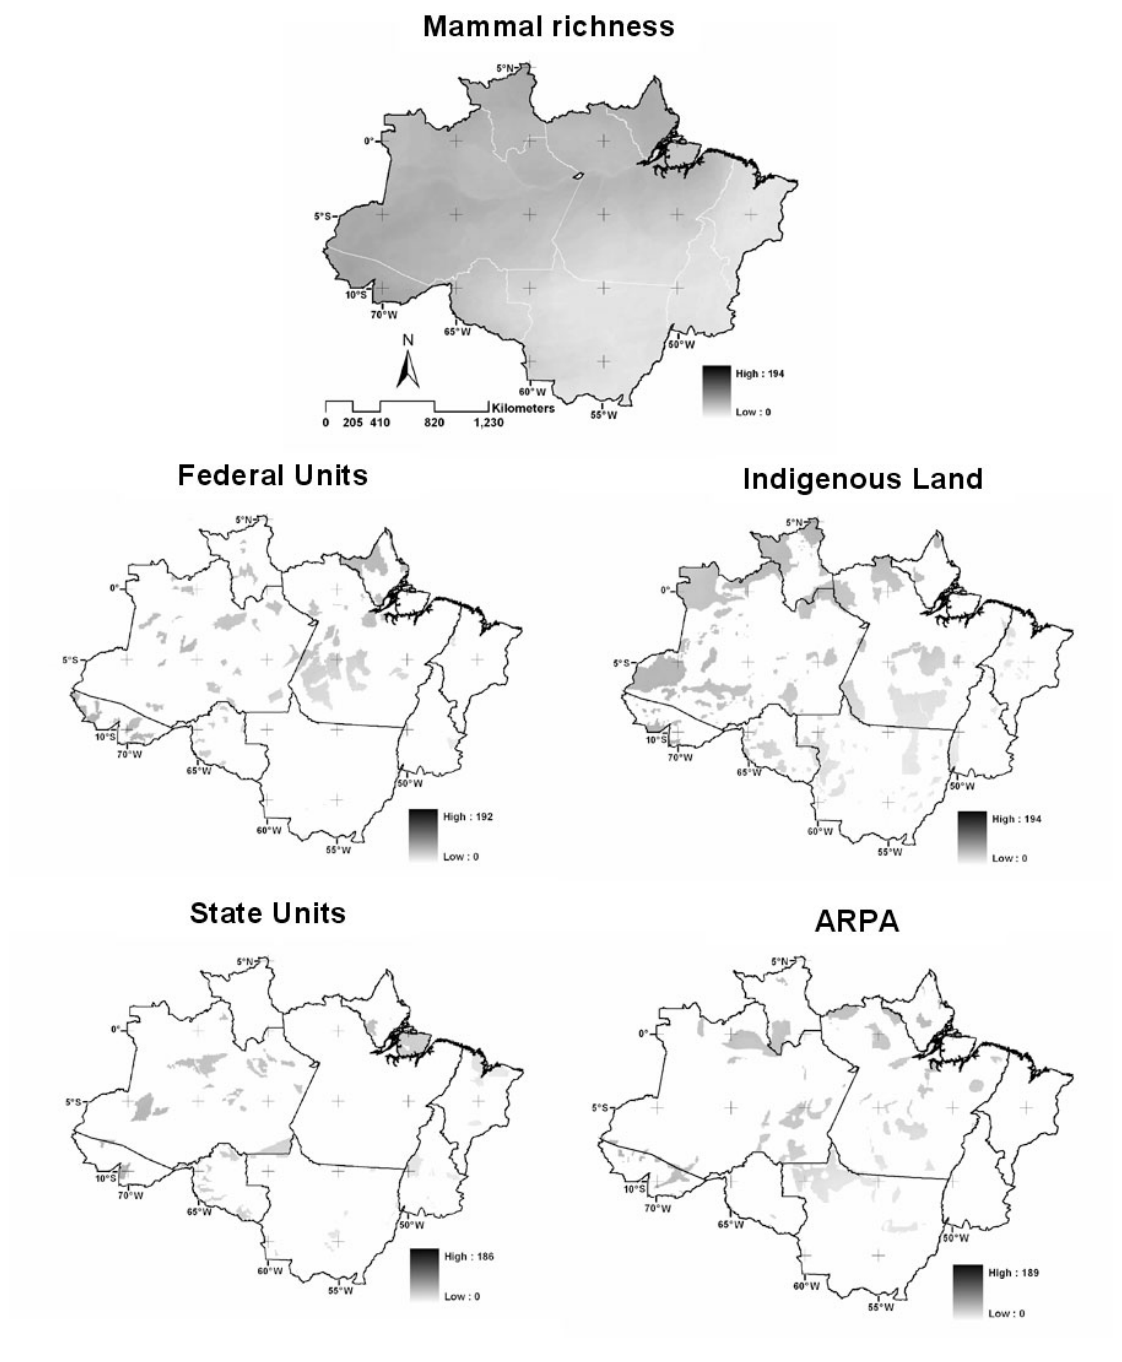
Fig. 2. Map of richness of mammal ranges ( N = 399) for Amazonia superimposed on main protected areas: federal conservation units, state conservation units, indigenous land, and Amazon Region Protected Areas (ARPA). The darker the color, the higher the